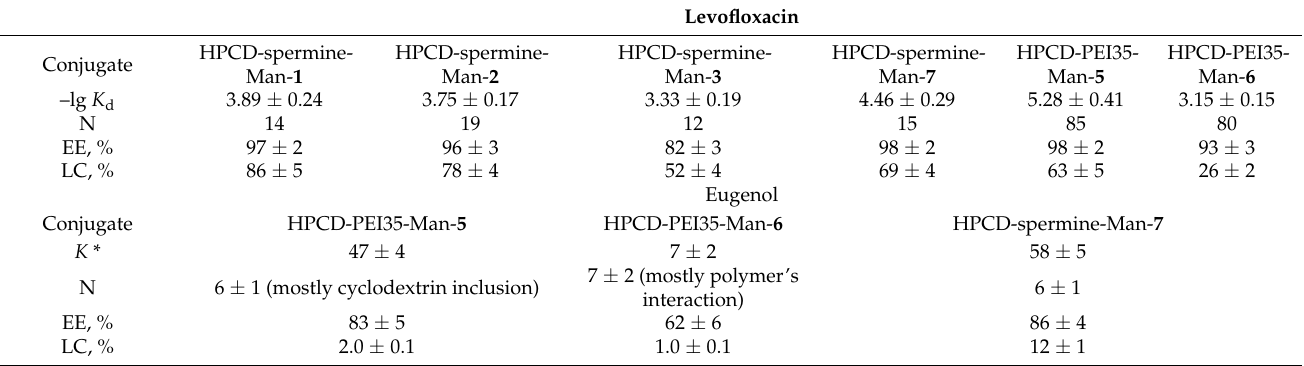
Table 3. Dissociation and equilibrium constants of conjugates’ complexes with levofloxacin and eugenol determined by FTIR spectroscopy. Maximum loading capacity (N) of the drug into conjugates. Entrapment efficiency (EE) and loading capacity (LC) of levofloxacin and eugenol by molecular containers. The conditions are given in the Methods